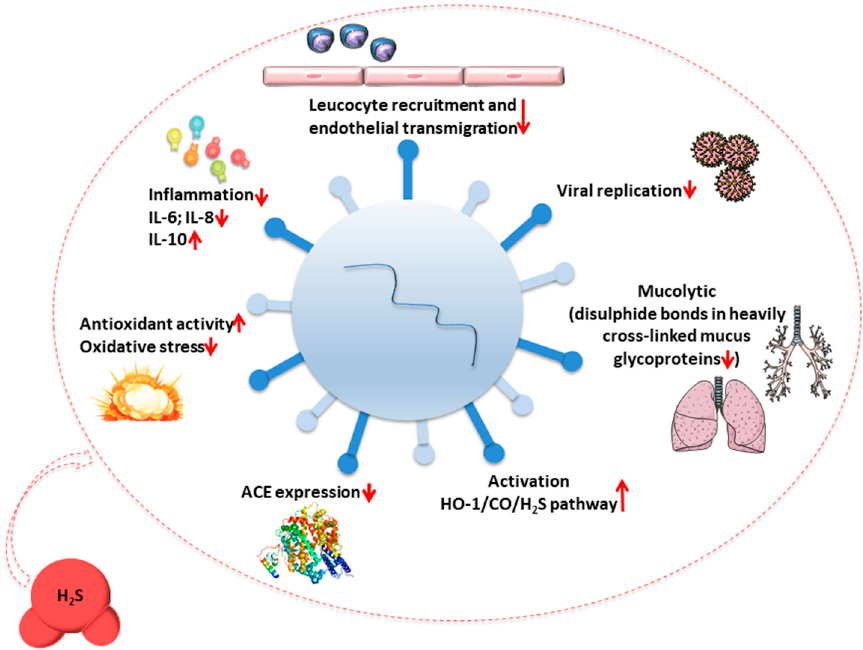
Figure 2. Primary biological mechanisms involving H 2 S (donors) in the protective response against SARS-CoV-2. Following viral infection, H 2 S counteracts inflammation by decreasing levels of IL-6 and IL-8, inducing an increase in IL-10 concentration and inhibiting the recruitment of leukocytes to the endothelium. It also represses ACE expression, which in turn leads to vasodilation, decreased inflammation and oxidative stress, and reduced fibrosis. H 2 S donors enhance endogenous antioxidant defenses and play a mucolytic role. The activity of H 2 S also results in the activation of the HO- 1/CO/H 2 S system and inhibition of virus replication. Abbreviations: ACE: Angiotensin-converting enzyme; CO: Carbon monoxide; H 2 S: Hydrogen sulfide; HO-1: Heme oxygenase-1; IL: interleukin.